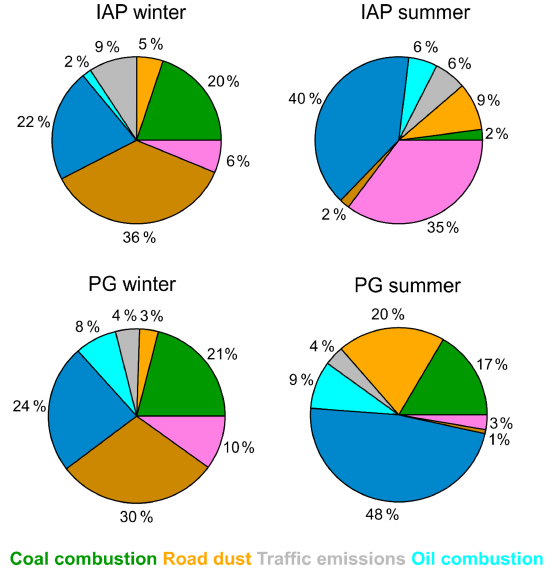
Figure 3. Contribution of different sources to PM 2 . 5 mass at IAP and